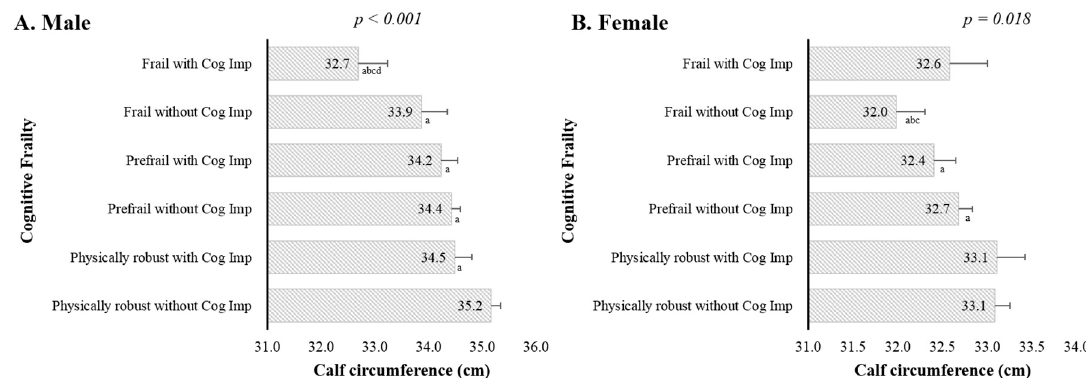
Figure 2. ( A ) male; ( B ) female. Geometric mean (±SE) calf circumference according to physical frailty and cognitive impairment status. The multivariate analyses were adjusted for Model 3 (age, alcohol, years of education, comorbidity, medication, and body mass index). p -value from test for linear trend. SE = standard error; Cog Imp = cognitive impairment. Differences determined by post-hoc analysis were considered significant at p < 0.05. a Significantly different from physically robust without Cog Imp group. b Significantly different from physically robust with Cog Imp group. c Significantly different from prefrail without Cog Imp group. d Significantly different from prefrail with Cog Imp group.